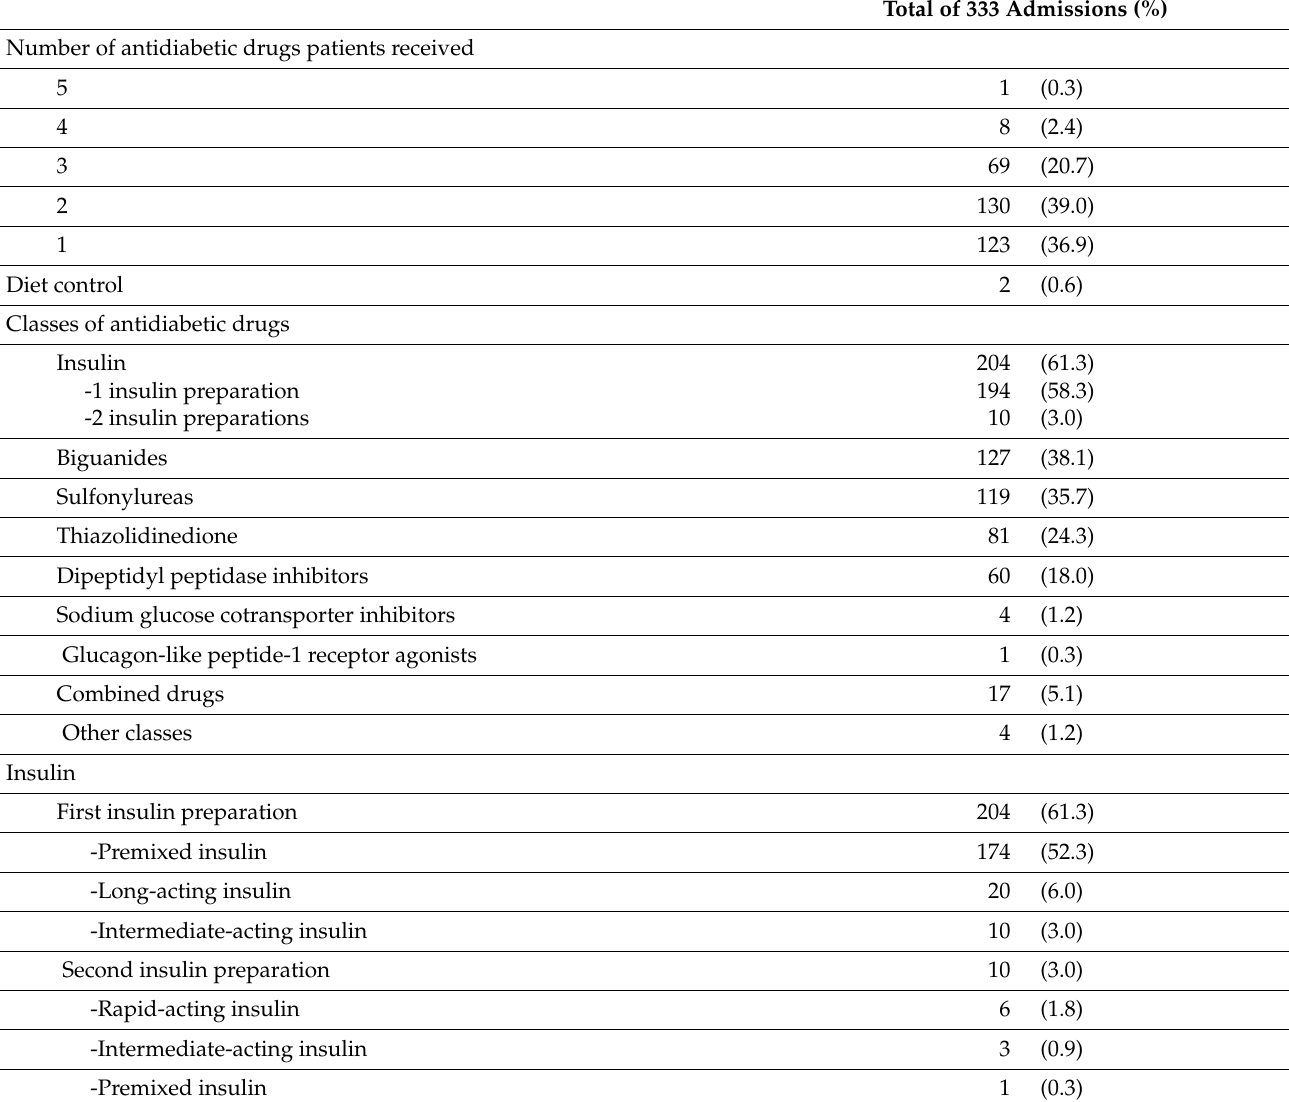
Table 2. Antidiabetic treatment used among admitted